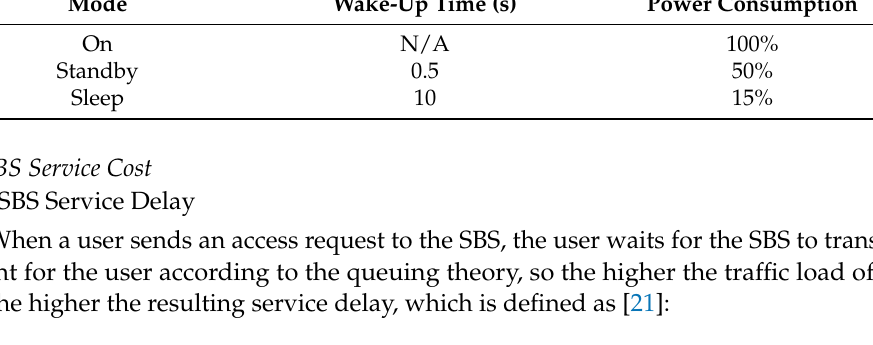
Table 1. Wake-up time and power consumption of SBS in different states [20]. Mode Wake-Up Time (s) Power Consumption On N/A 100% Standby 0.5 50% Sleep 10